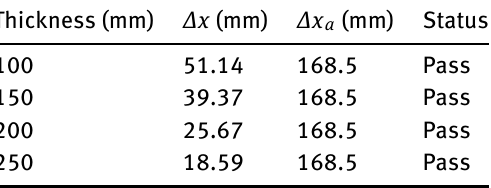
Table 5: Comparison of deformation values at different plate thick- nesses.